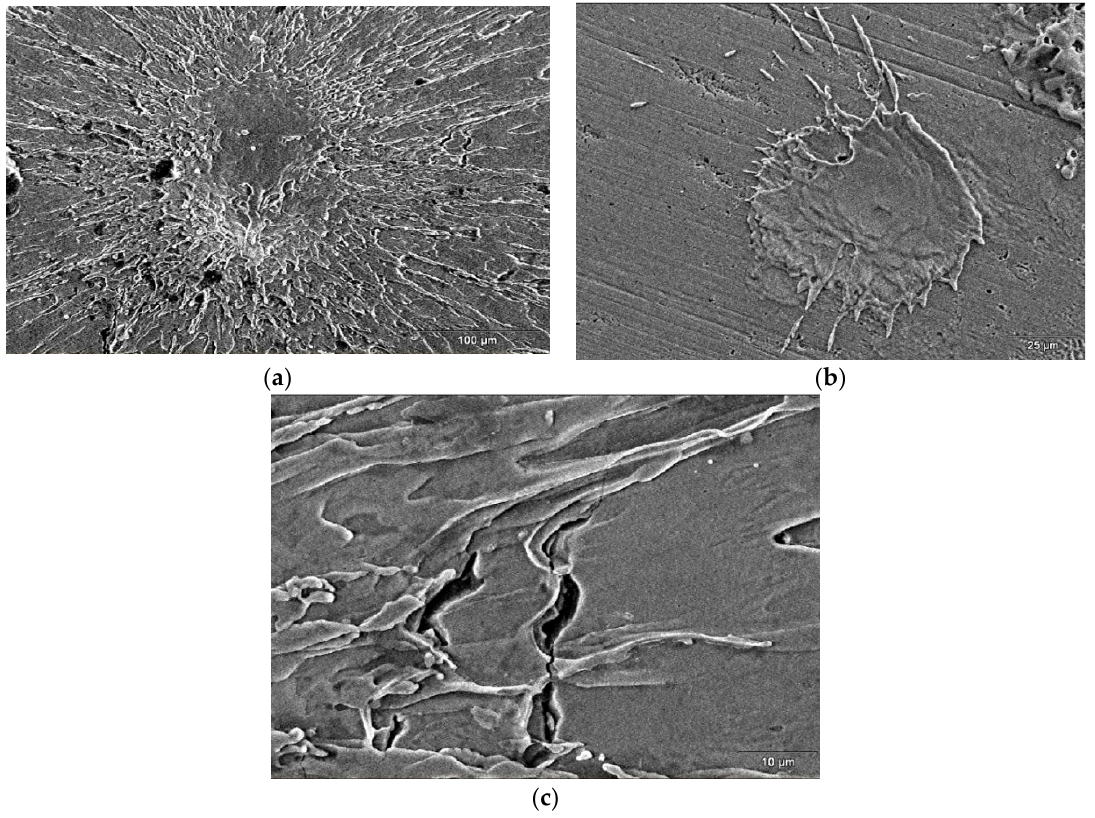
Figure 5. SEM micrographs displaying the zone irradiated by the laser pulse: ( a ) the crater; ( b ) the splash of molten metal ejected from the crater; and ( c ) a detail of the crater at a higher magnification showing some cracks.